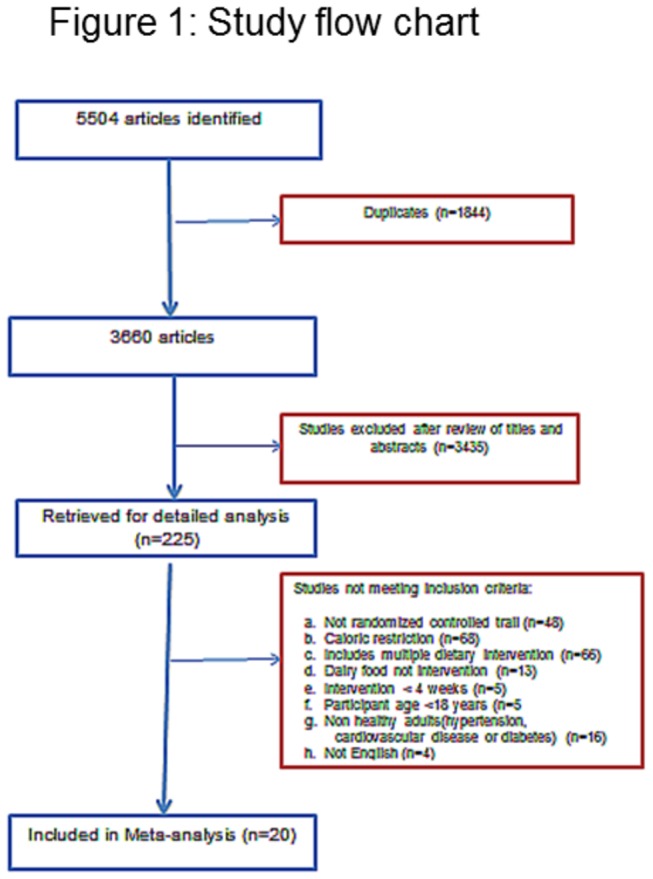
Study flow chart.